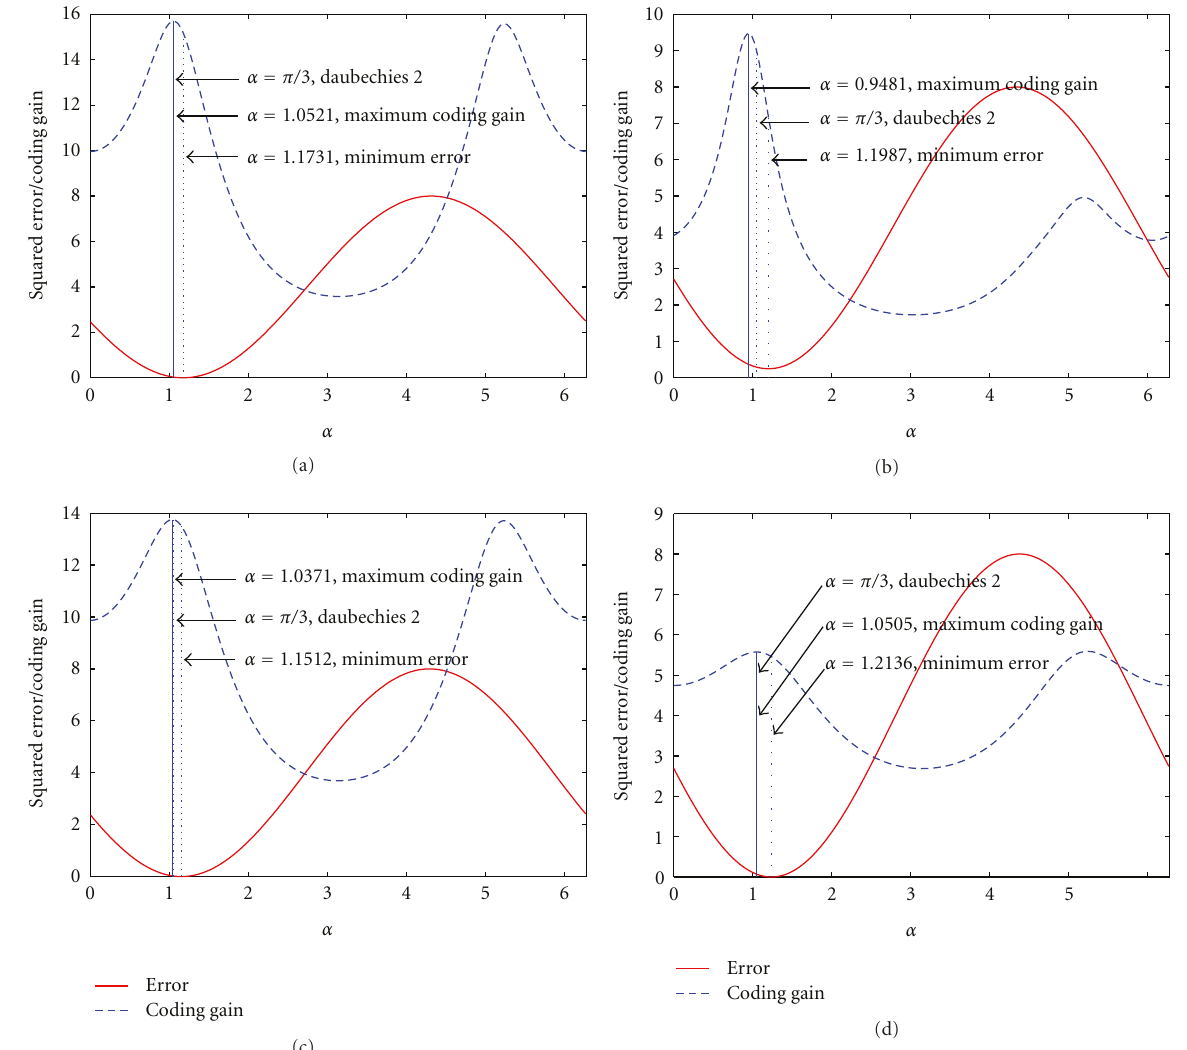
Figure 4: Graphs of coding gains and errors for test images: (a) Lena, (b) Mandrill, (c) Peppers, and (d) Bridge.